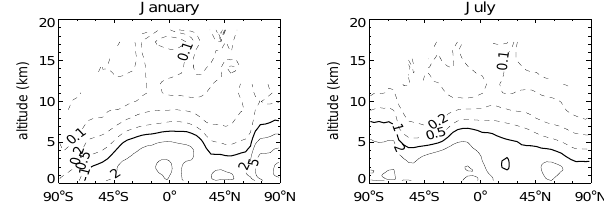
Fig. 4. Zonal mean ratio of γ HO values calculated using the parameterisation in this work, and those using the parameterisation of Thornton et al. (2008). Using laboratory data (this work) yields lower values of γ HO in the upper troposphere (dashed lines) and higher values nearer the surface (solid lines) than the parameterisa- tion of Thornton et al.